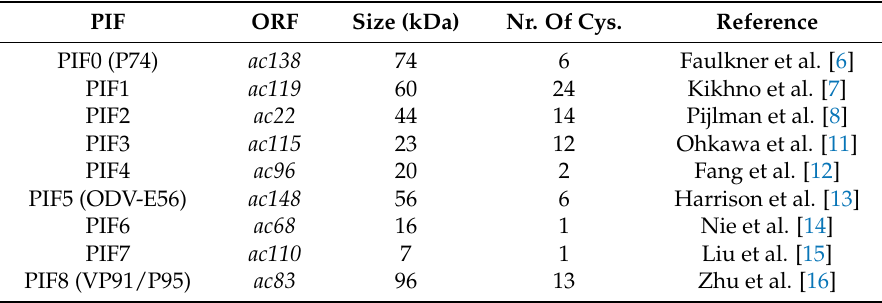
Table 1. Identified PIFs in